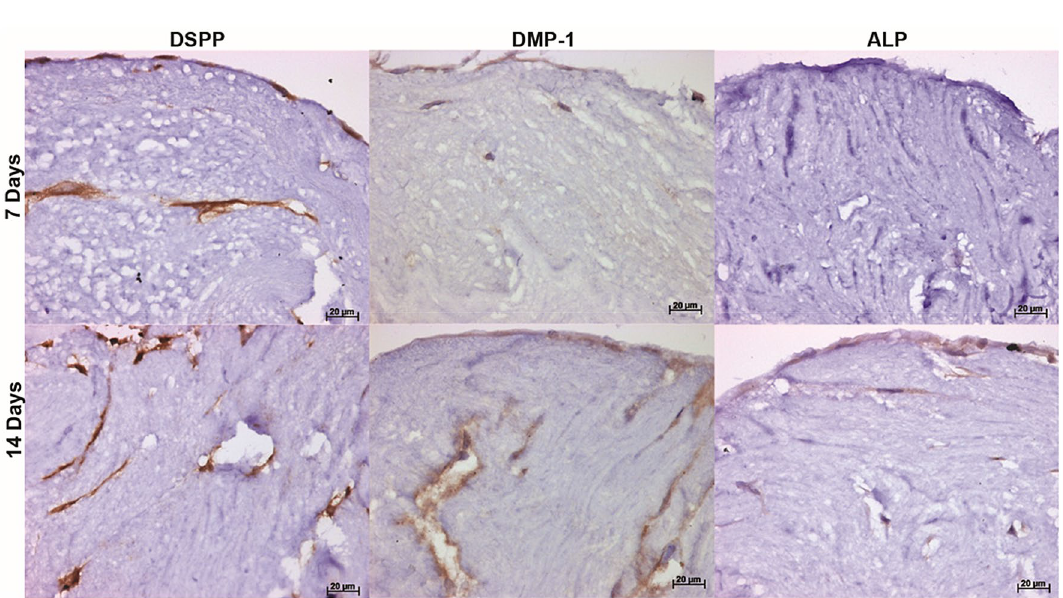
Figure 7. Odontoblastic markers following recellularisation of the decellularised pulp scaffold. Representative images of immunohistochemical labelled tissues showing a positive immunoreactivity against DSPP positive cells at 7 and 14 days culture. DMP-1 and ALP, were weakly stained at day 7 with an increase in staining intensity at day 14. DSPP dentine sialophospoprotein, DMP-1 dentine matrix protein 1, ALP alkaline phosphatase. Scale bars are at 20